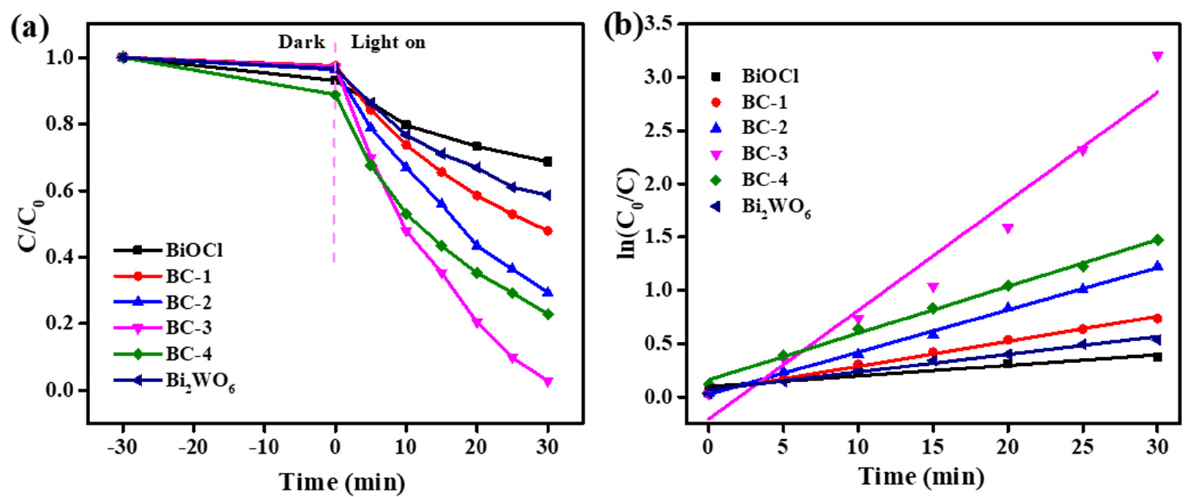
Figure 8. Degradation curves of BPA with PMS activation over the Bi 2 WO 6 /BiOCl nanocomposites with various contents of Bi 2 WO 6 ( a ) and the corresponding kinetics fitting curves ( b ). Reaction condition: initial BPA concentration of 10 mg/L, PMS dosage of 1 mmol/L, catalyst addition of 1 g/L.